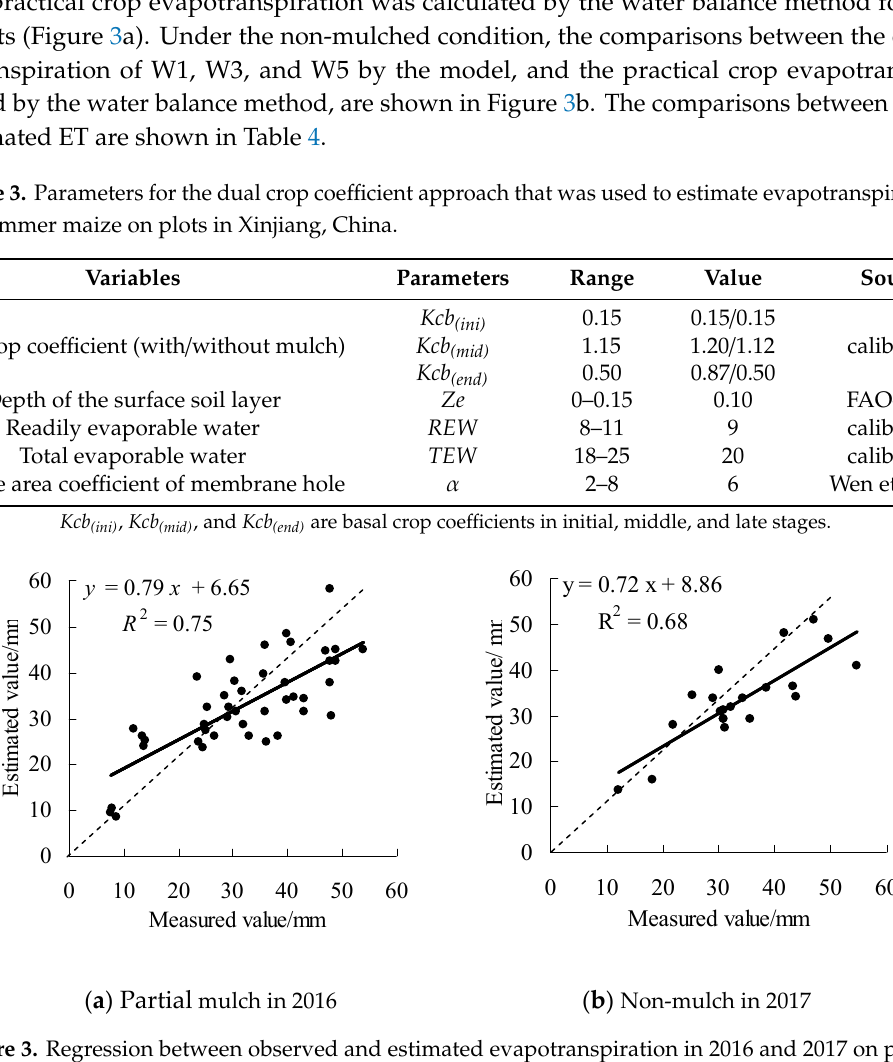
Figure 3. Regression between observed and estimated evapotranspiration in 2016 and 2017 on partial mulched and non-mulched plots in Xinjiang, China. ( a ) Partial mulch in 2016; ( b ) non-mulch in 2017. Table 4. Statistics of observed and estimated evapotranspiration in 2016 and 2017 on partial mulched and non-mulched plots in Xinjiang, China.